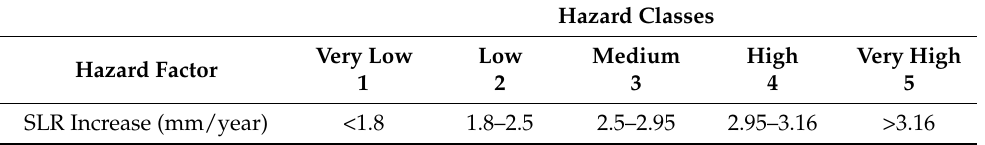
Table 8. Hazard classification concerning the sea level rise (SLR) hazard